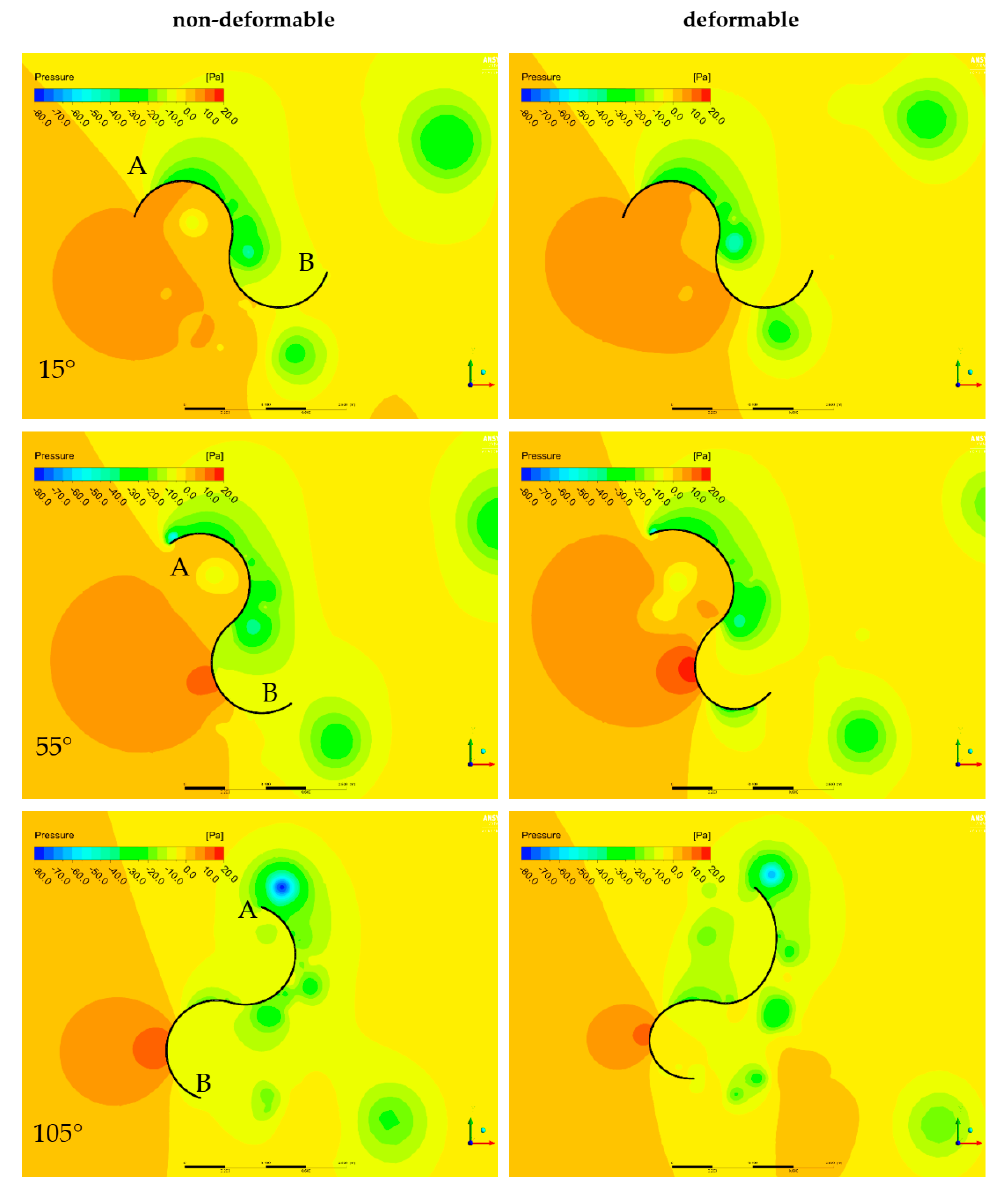
Figure 11. Pressure fields for selected instants (15°, 55° and 105°) of one revolution of the rotors with non-deformable and deformable blades. non-deformable and deformable